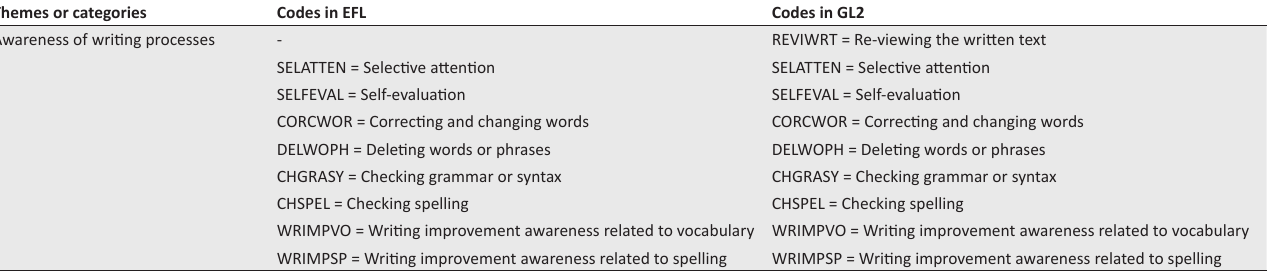
TABLE 3: Categories and codes of the thematic strand ‘metacognitive processes and strategies’. Themes or